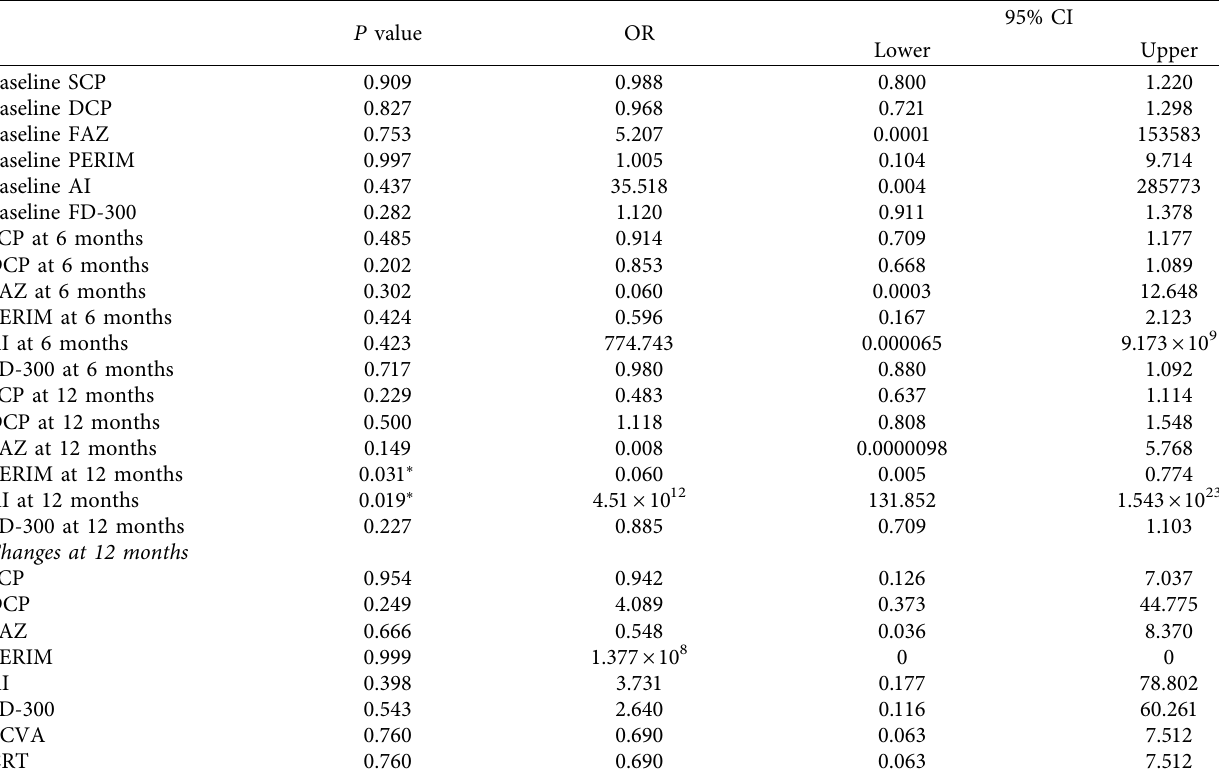
Table 6: Correlations between the evaluated parameters and the recurrence of macular edema within 12